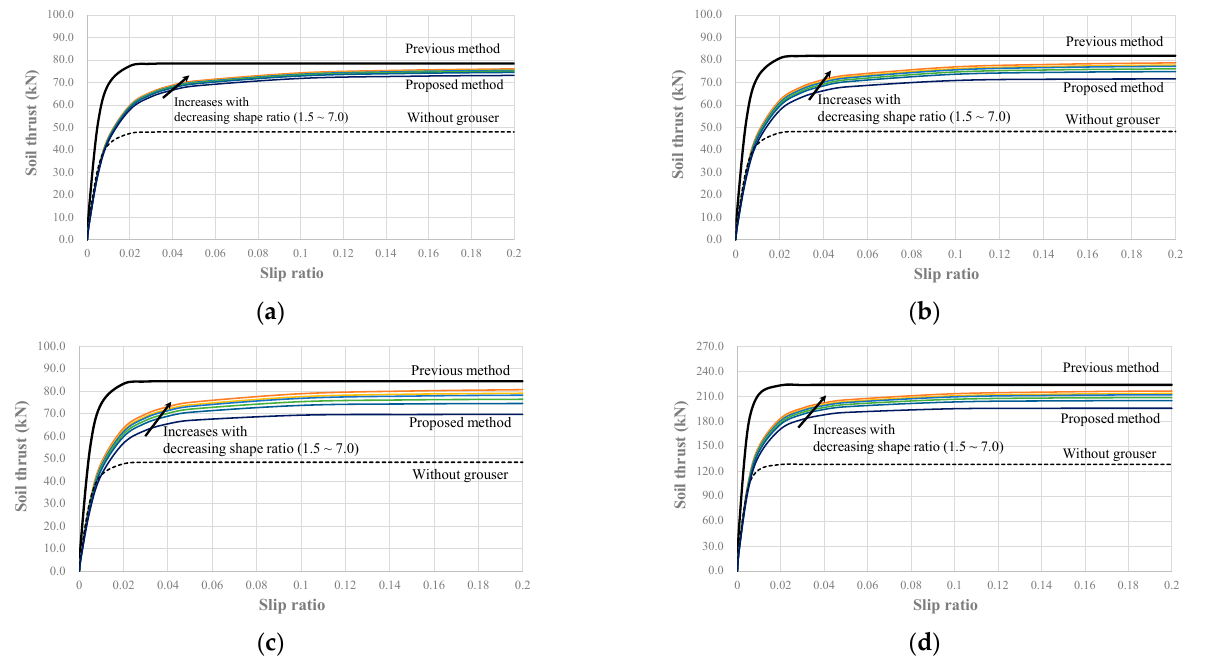
Figure 6. Soil thrust and slip displacement curves in soils exhibiting hardening behavior ( c = 0.96 kPa, 𝜙 = 27.3° , K = 1.14): EC145E with a grouser height of ( a ) 25 mm, ( b ) 50 mm ( c ) 70 mm: ( d ) EC380E with 70 mm grouser height.